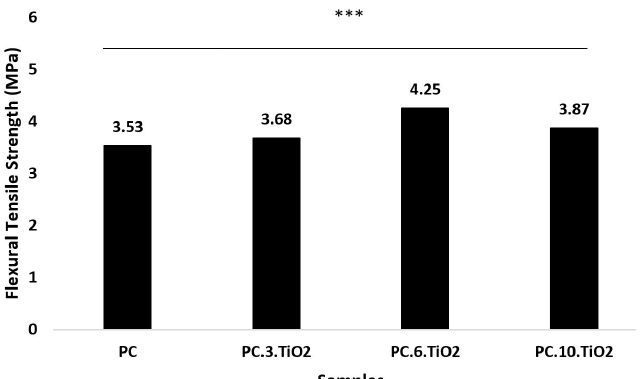
Figure 14 Average of the samples obtained in the Flexural Tensile Strength test. *** Statistically significant difference by the Tukey test p